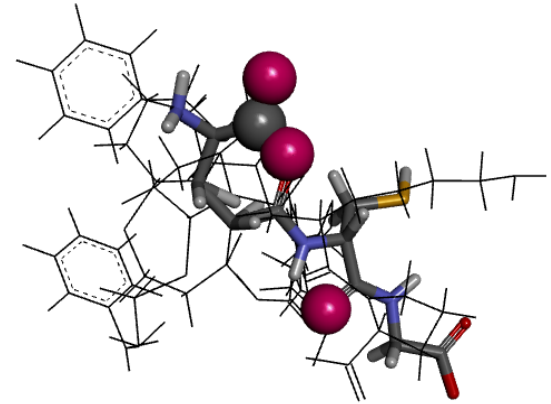
Figure 14. Spatial fitting of glutathione to the angiotensin-converting enzyme (ACE) antagonist pharmacophore. Hydrogen-bond acceptors and negative pharmacophore features are represented in red and gray, respectively.